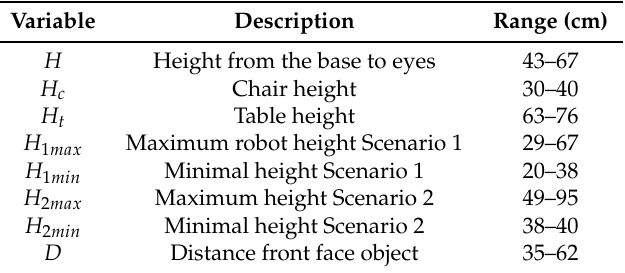
Table 2. Variables used and parameters estimated in the ergonomic analysis.